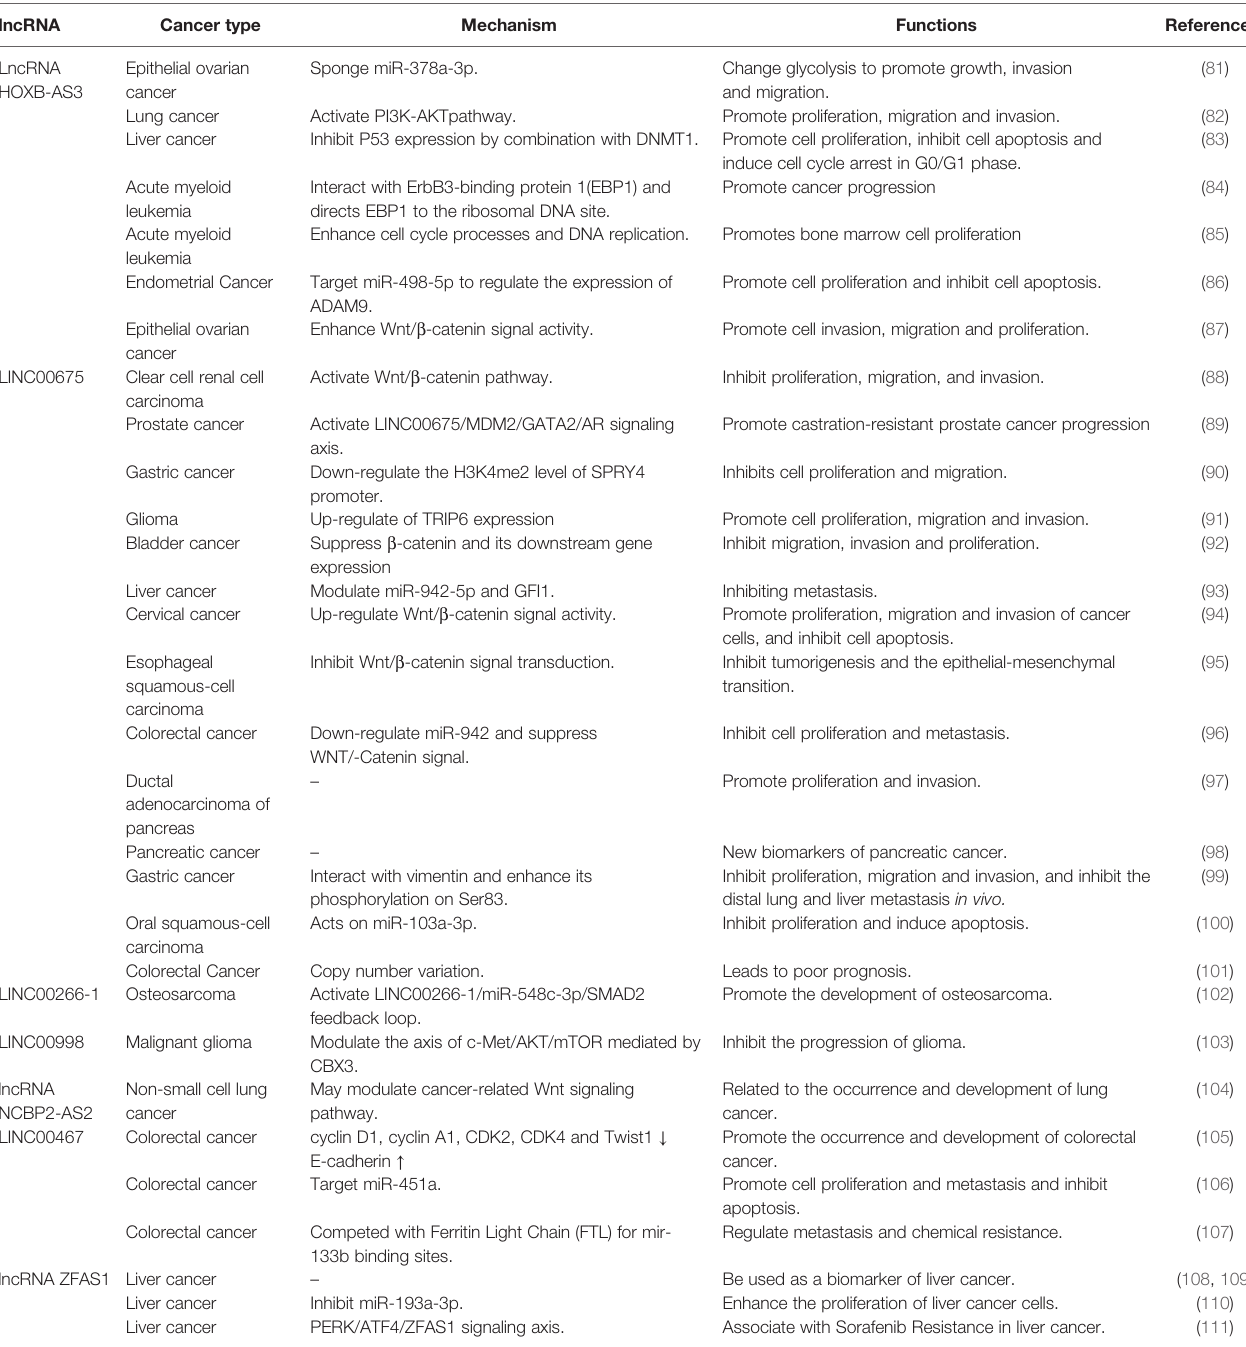
TABLE 2 | Studies of lncRNAs at RNA